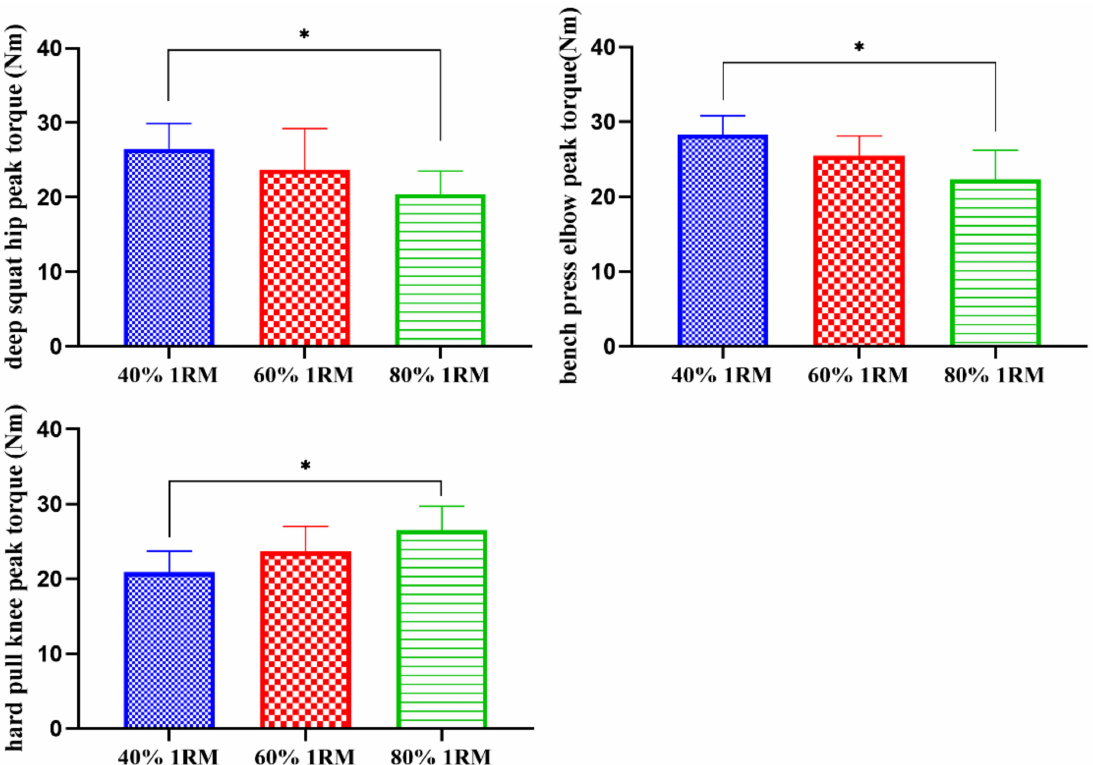
Figure 8. Comparisons of the different load intensity test peak muscle strength (N). * There was a significant difference between 40% 1RM and 80% 1RM ( p < 0.05).